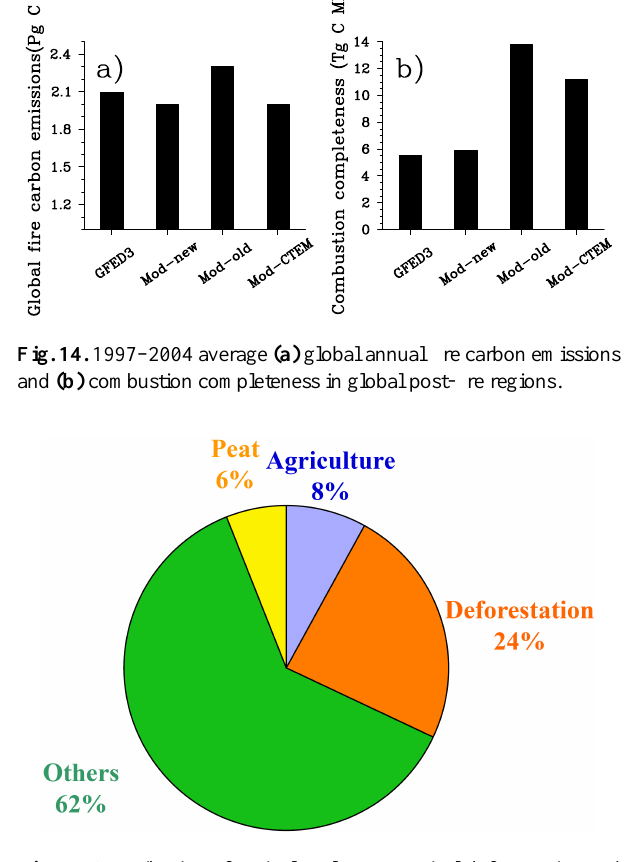
Fig. 15. Contribution of agricultural fires, tropical deforestation and degradation fires, non-peat fires outside cropland and tropical closed forests, and peat fires to 1997–2004 global fire carbon emissions from